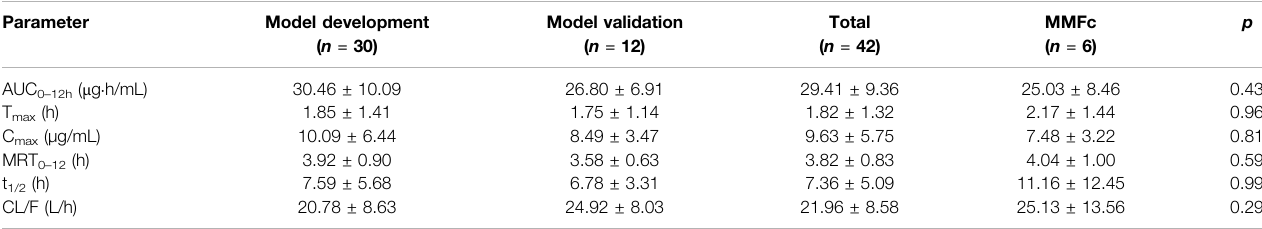
TABLE 2 | Pharmacokinetic parameters of MMFdt and MMFc in heart transplant